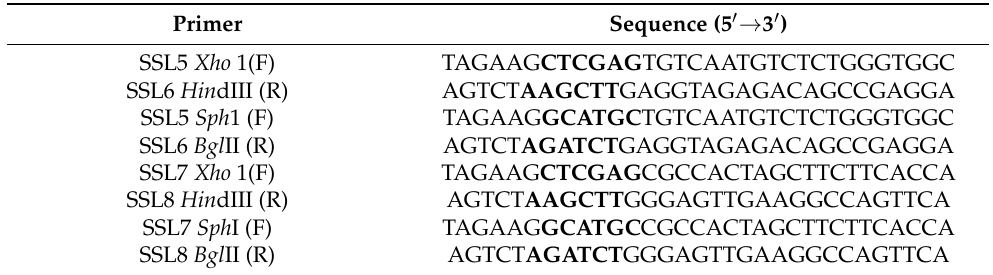
Table 1. PCR primers used for swnT cloning. Restriction sites are in boldface type.